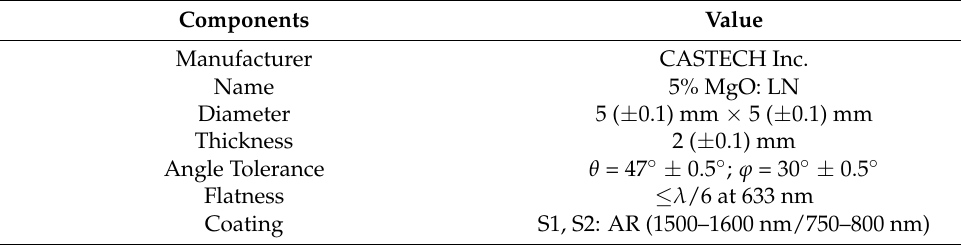
Figure 6. ( a ) FW spectrum before conversion; ( b ) second harmonic wave (SHW) spectrum focusing by a parabolic mirror; ( c ) SHW spectrum focusing by a lens. Table 3. LiNbO 3 crystal